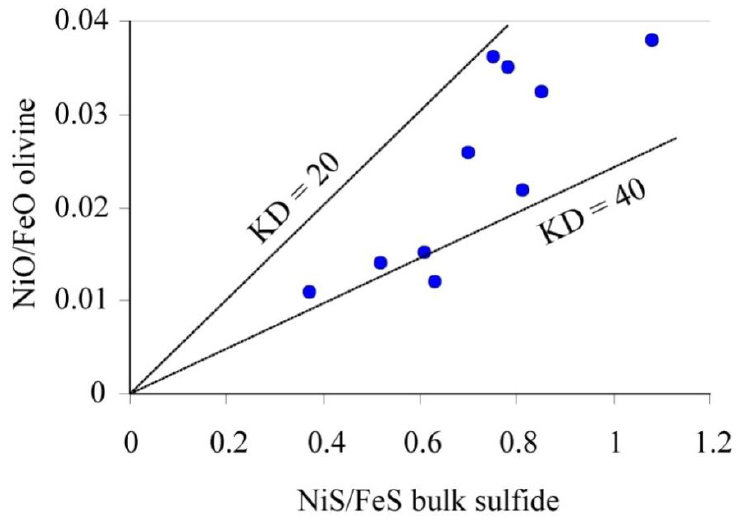
Figure 3. Relationships between the NiO/FeO ratio in olivine and the NiS/FeS ratio in the coexisting sulfides from the partially serpentinized dunite hosting CHR-1 chromitite layers. Lines of constant distribution-coefficient KD = 20 and KD = 40 are indicated. The NiS/FeS ratio in sulfide was calculated combining the modal proportion and microprobe composition of pentlandite, chalcopyrite, and pyrrhotite constituting the interstitial droplets in the dunite.